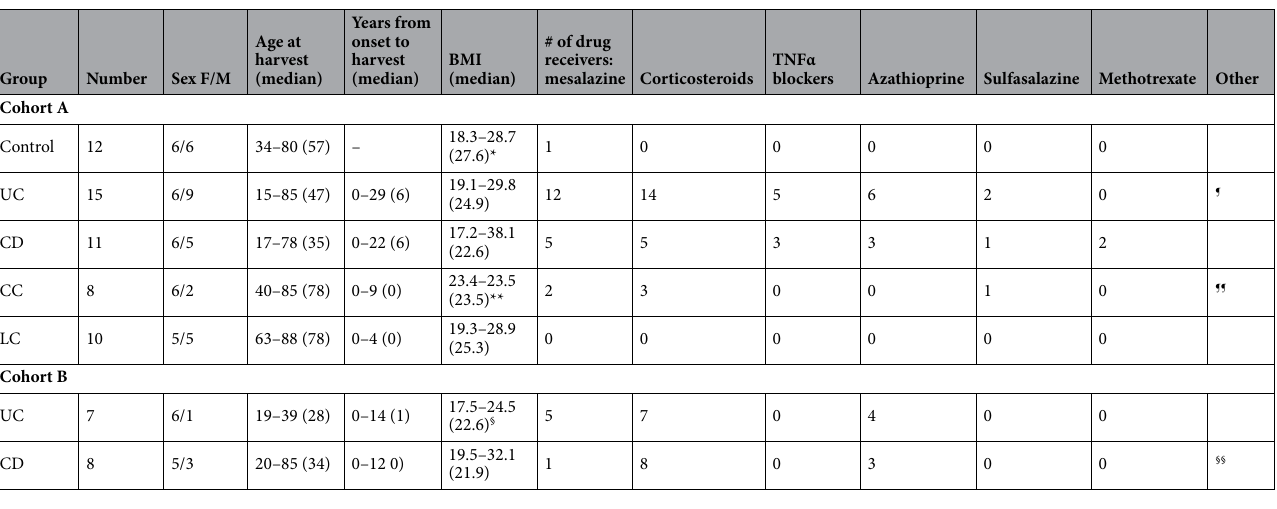
Table 1. Clinical characteristics and medication of patients. The numbers in the medical treatment columns indicate the number of patients receiving this medication within 1 month prior to tissue or biopsy harvest. *Only 4 values available. **Only 2 values available. ¶ Single users of allupurinol, ursodiol and anabolic steroids. ¶¶ Single users of leflunomide and hydroxychloroquine. § Only 5 values available. §§ Single user of